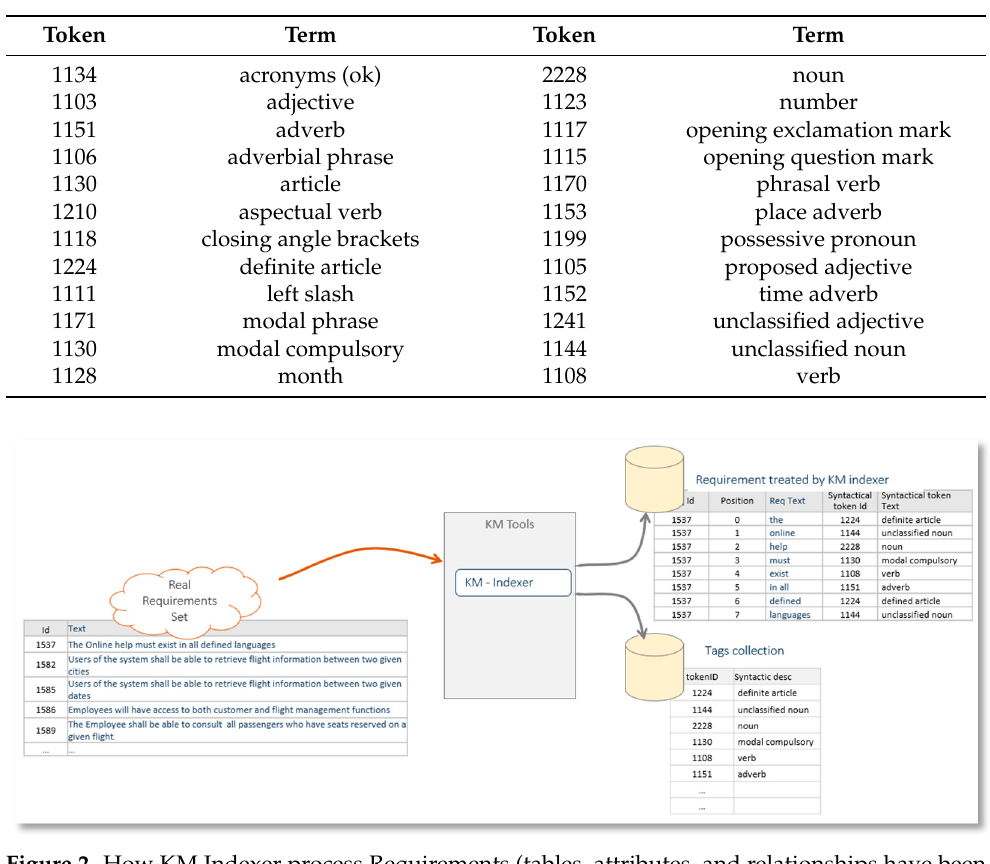
Table 1. Sample table of tokens from Reuse SE tools.